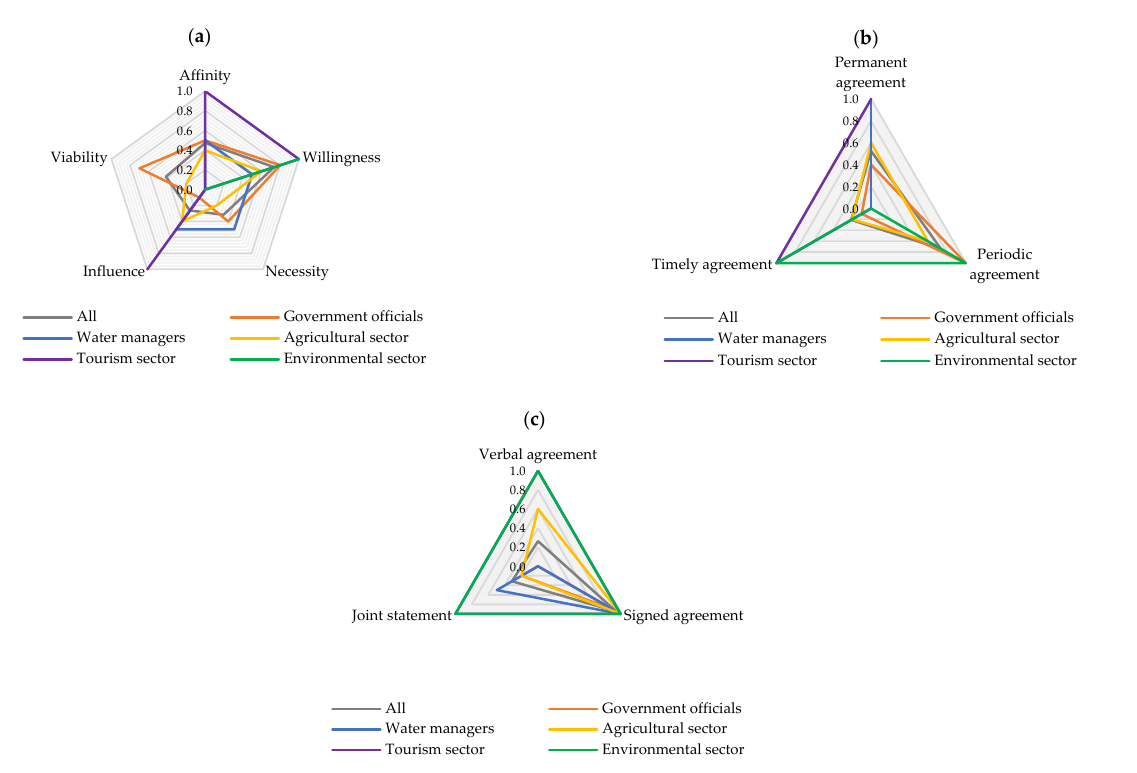
Figure 12. Agreement characteristics according to stakeholders’ perception. ( a ) Agreements benefited by; ( b ) Agreements time frame; ( c ) Agreements form.